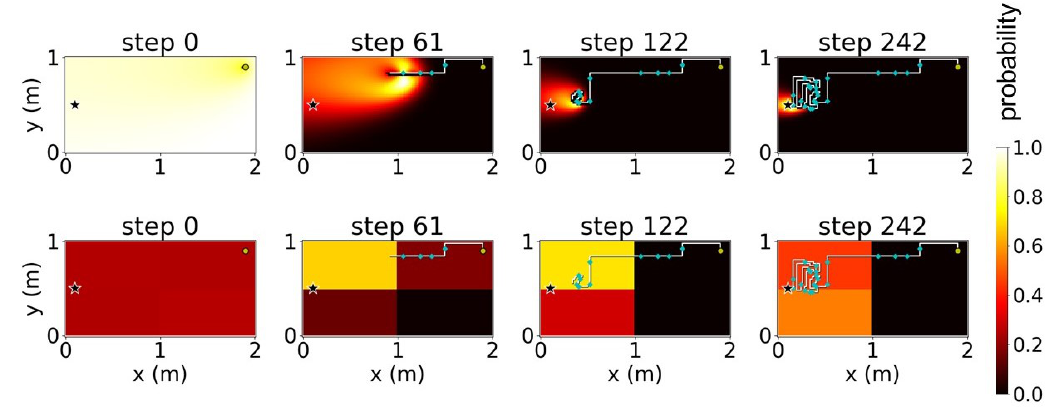
Figure 9. Timeline of a search using environment decomposition with the number of sub- environments ( K ) = 4 and stand-out coefficient ( ρ ) = 2. The star indicates odor source location.